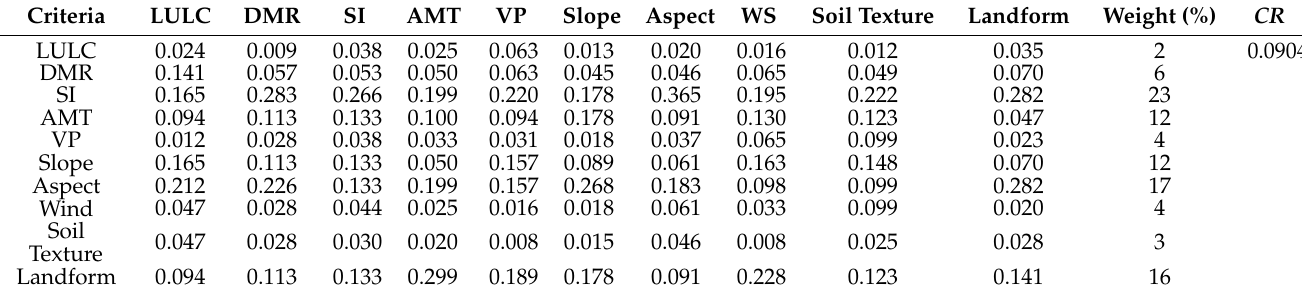
Figure 3. Map of the study area showing the restricted areas for the development of solar farms. Table 8. Normalized pairwise comparison matrix for the AHP